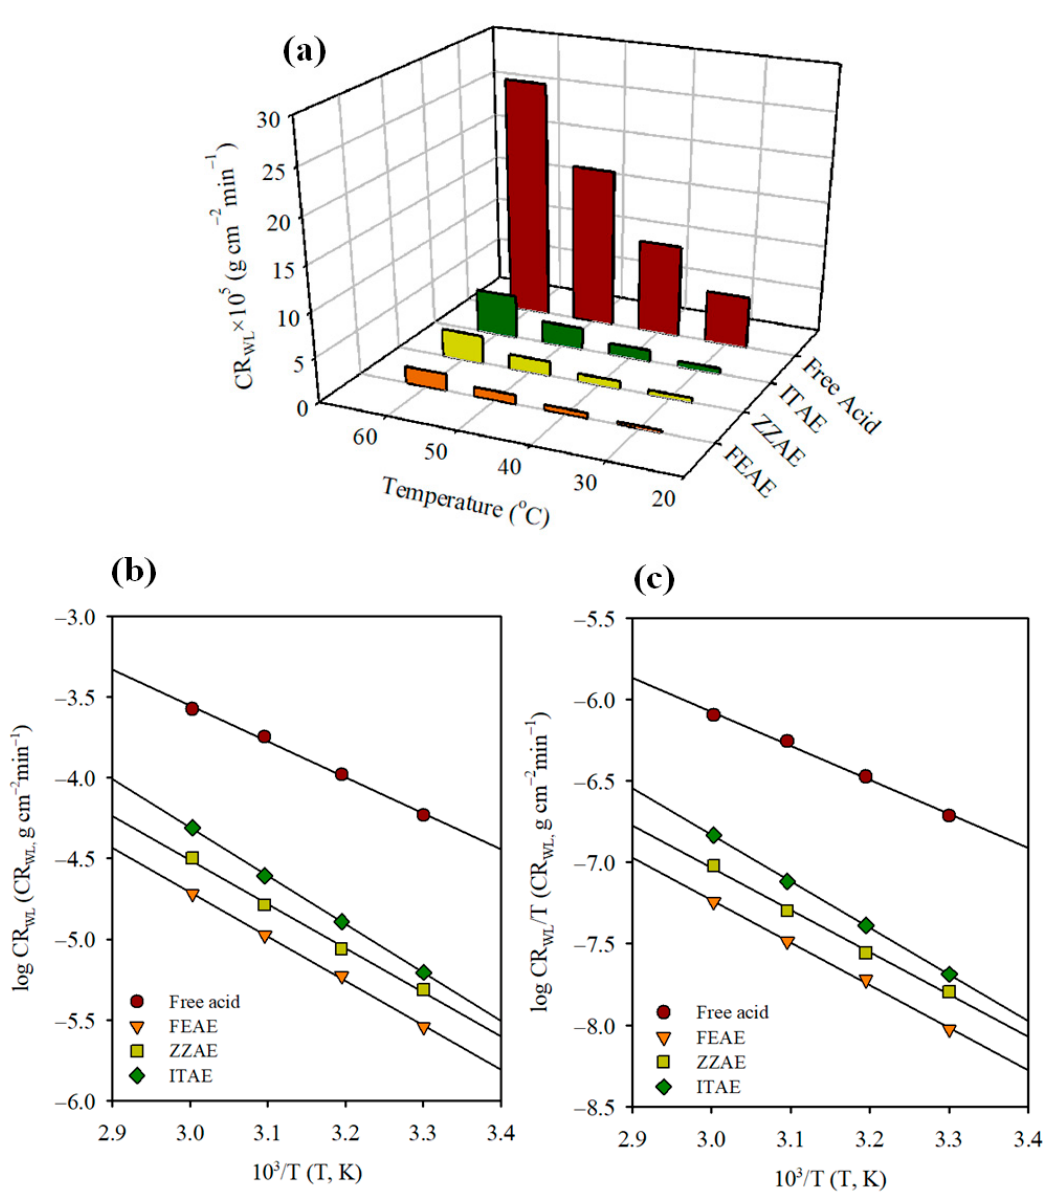
Figure 6. ( a ) Variation of CR WL with temperatures, ( b ) Arrhenius and ( c ) transition state plots for mild steel corrosion rates (CR WL ) in 2 M H 3 PO 4 with and without 2.5 g L − 1 of the studied plant extracts.